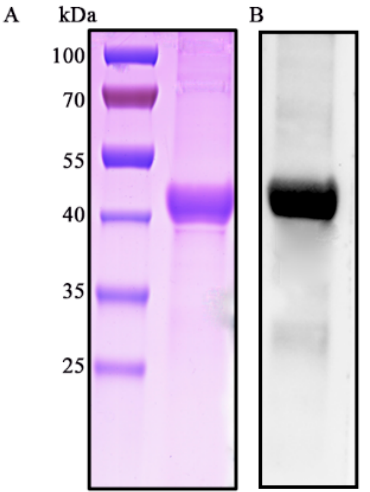
Figure 1. Purification of the recombinant HP1717 protein. ( A ) SDS-PAGE analysis. ( B ) Western blot analysis: the blot was probed with an anti-His tag monoclonal antibody (Cali-Bio).